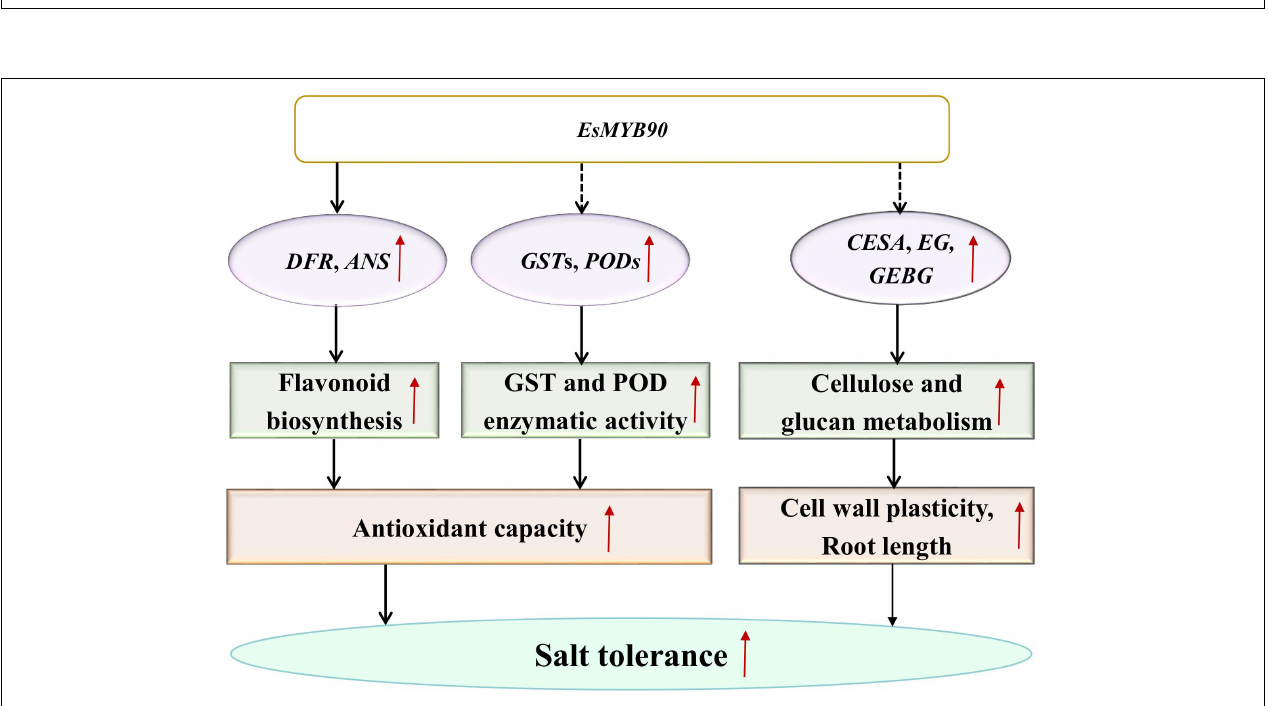
FIGURE 12 | A proposed model for the regulation mechanism of EsMYB90 in transgenic wheat. MYB, v-myb avian myeloblastosis viral oncogene homolog; GST, glutathione S-transferase; POD, peroxidase; CESA, cellulose synthase encoding genes; GEBG , glucan endo-1,3- β -glucosidase encoding genes; EG, endoglucanase encoding